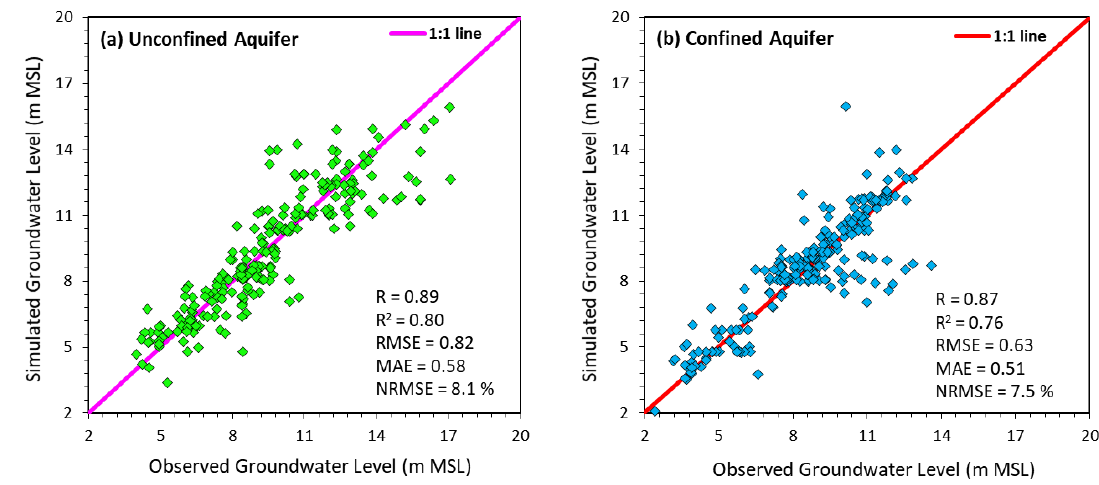
Figure 5. Scatter plots contrasting simulated and observed groundwater levels-in ( a ) unconfined aquifer and ( b ) confined aquifer during model validation period (modified from [62]).